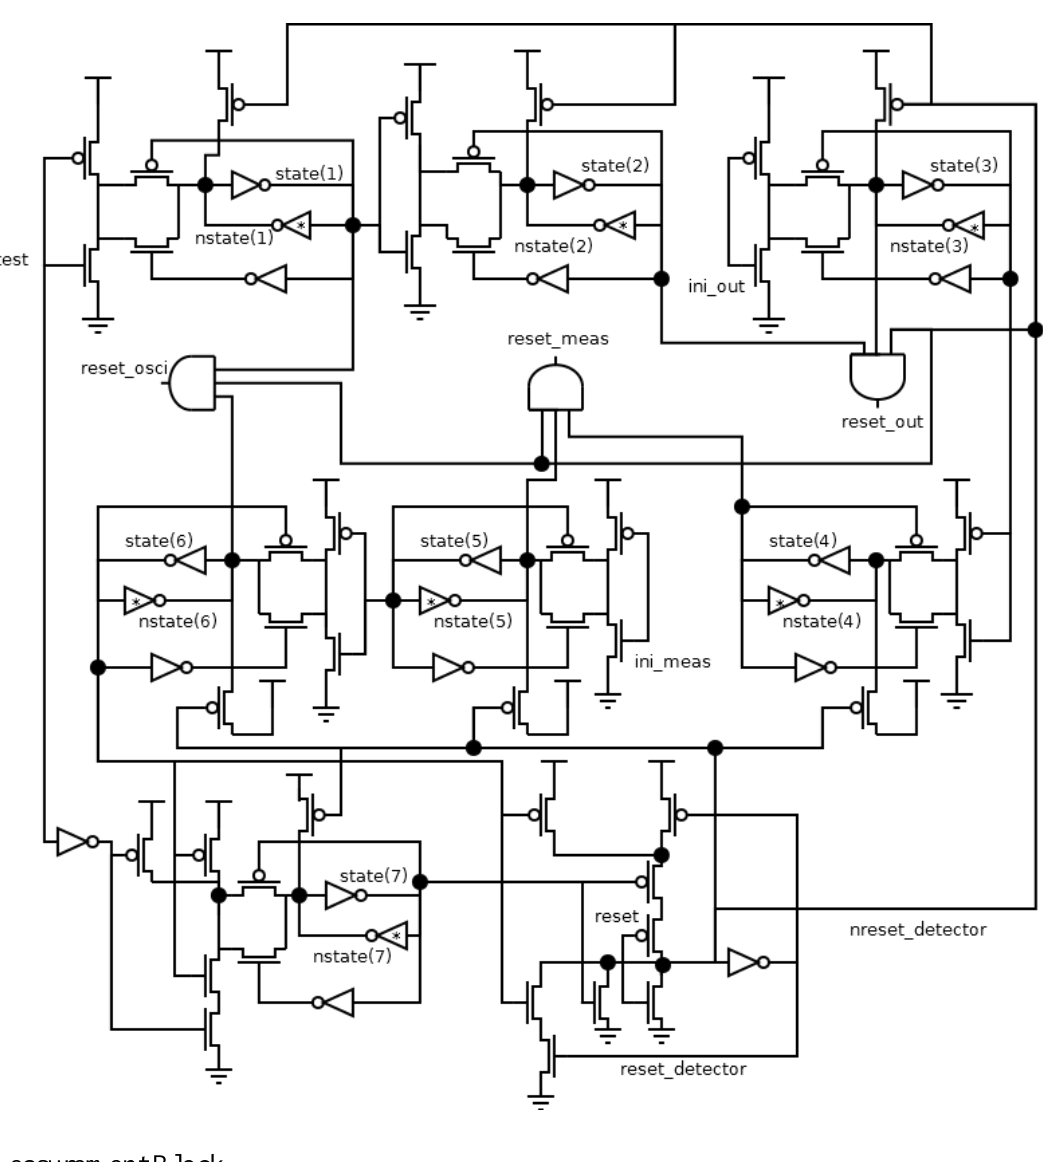
Figure 5. Schematic of the transition